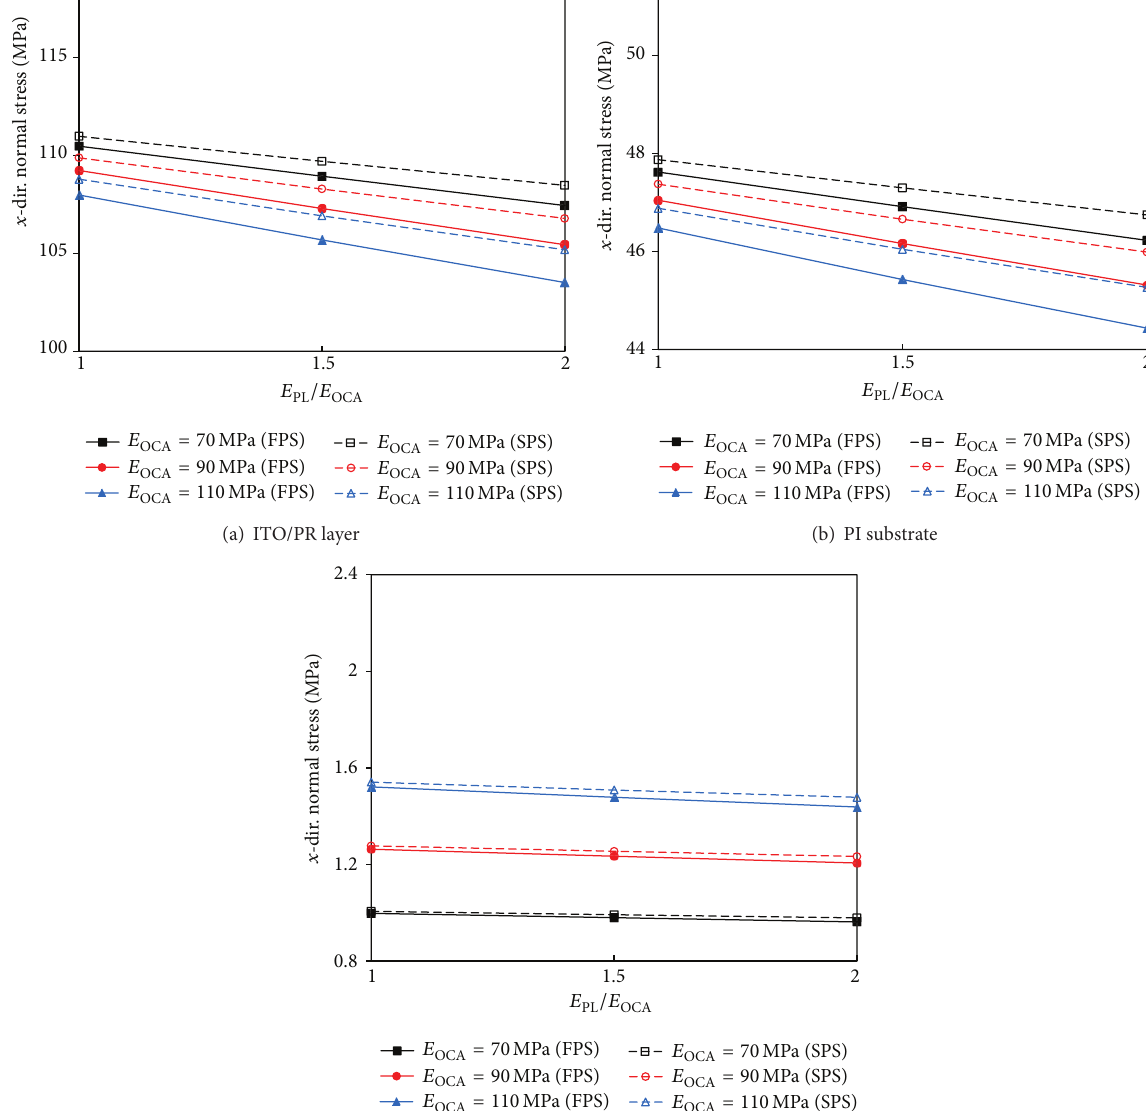
Figure 10: Effects of OCA Young’s modulus and 𝐸